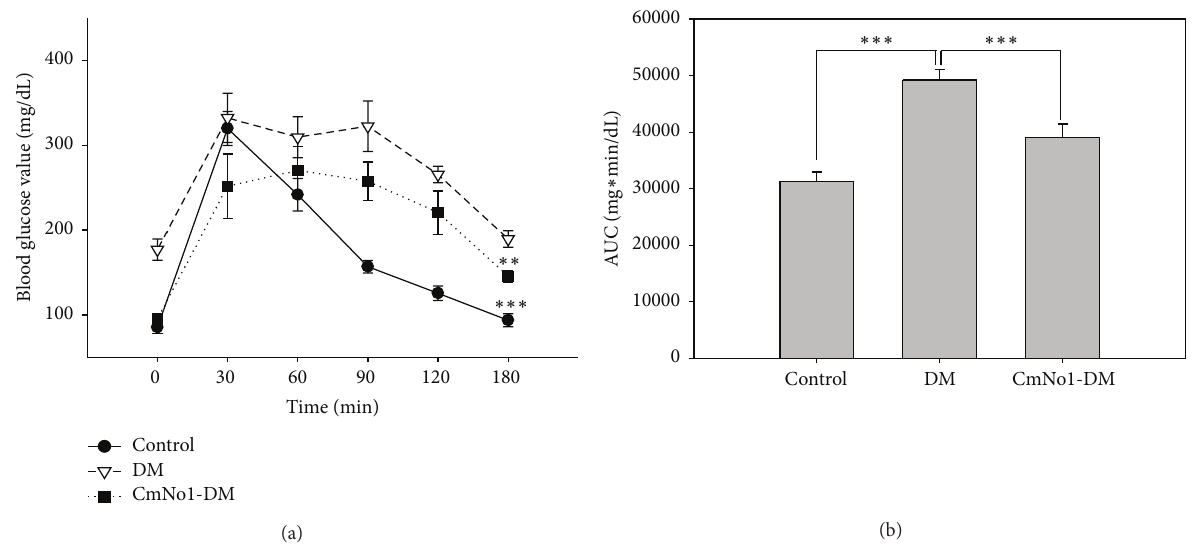
Figure 2: Assessment of glucose tolerance. (a) A plot of time-dependent glucose tolerance curves in control, DM, and eight-week CmNo1- treated DM mice (CmNo1-DM). OGTT followed overnight fasting, blood samples collection, and finally 3 g/kg D-glucose oral administration to determine the glucose level at 0, 30, 60, 90, 120, and 180 min. (b) Area under the curve (AUC) was calculated to determine glucose tolerance. Data is expressed as the means ± SEM ( 𝑛 = 6 /group). Symbols specify significant difference from DM with ∗∗ and ∗ ∗ ∗ indicating 𝑝 < 0.01 and 𝑝 < 0.001 , respectively.